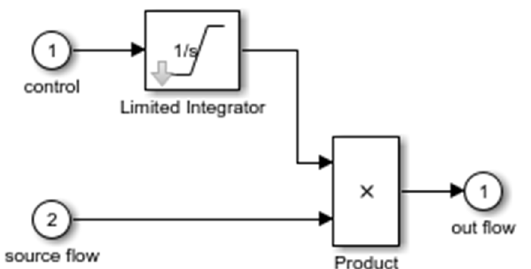
Figure 2. Model of Inlet Control Valve for Water Tank. Adapted with permission from [18].